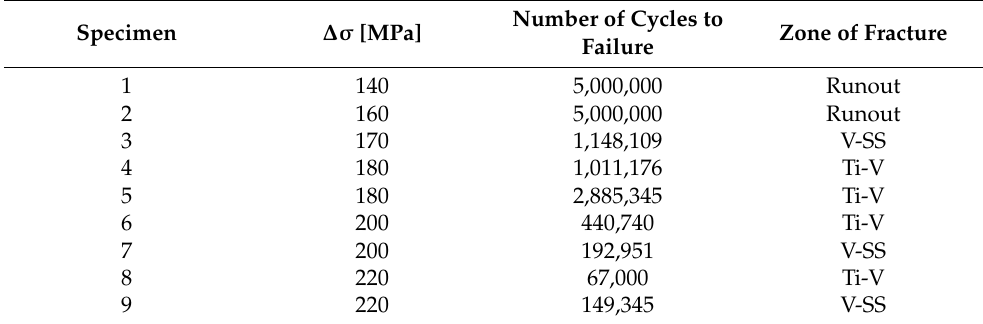
Table 6. Parameters and results obtained from fatigue tests, reprinted from [43] with permission from Elsevier.